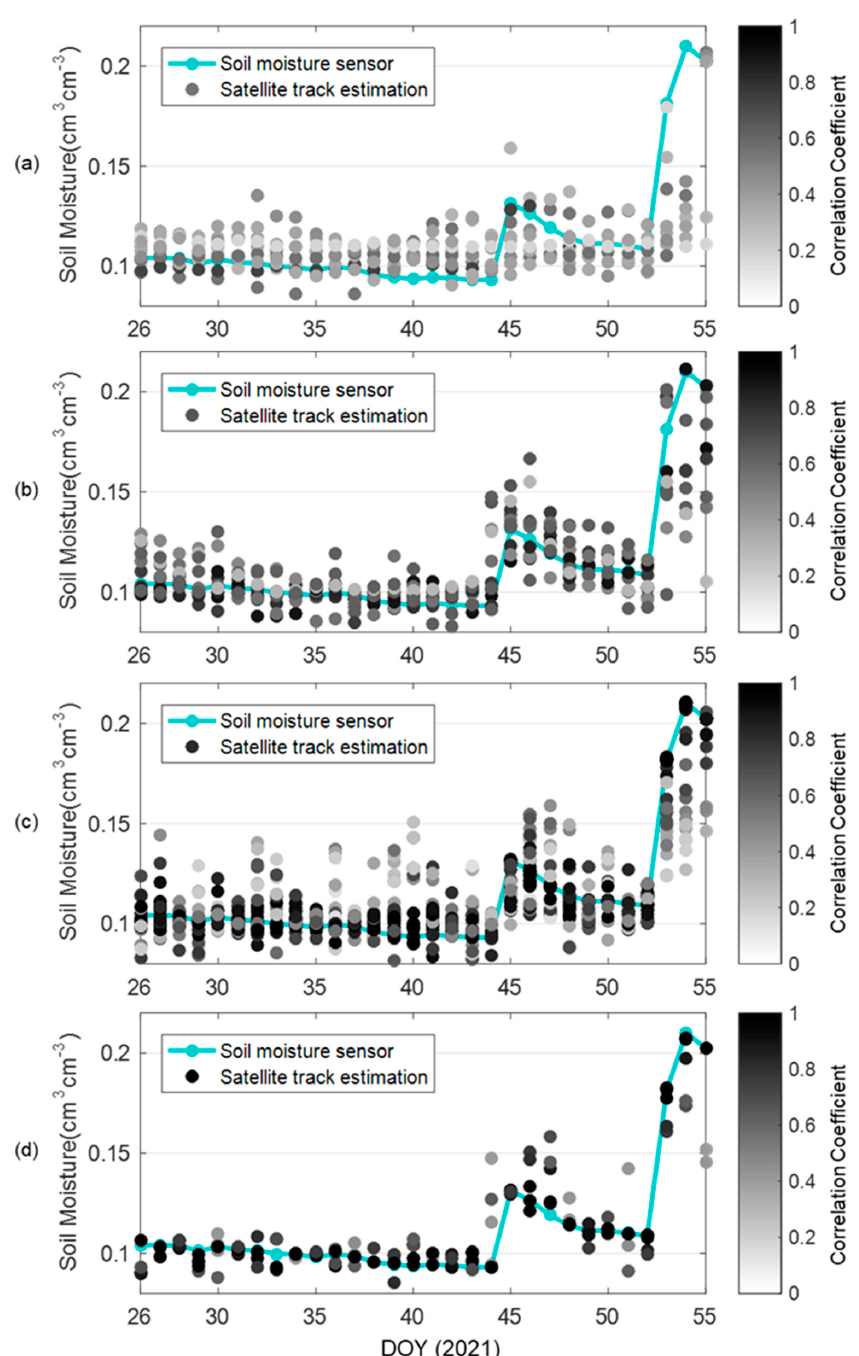
IGSO B2I satellite track estimations also respond better to the soil moisture changes. The dots of the IGSO B2I satellite track estimations have an obvious rise, while the dots of B1I only rise slightly.